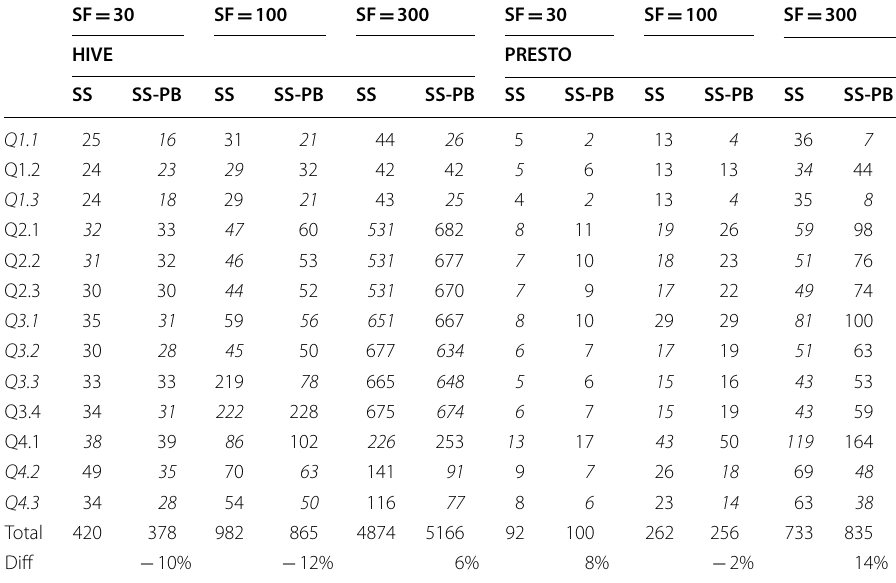
Italic values indicate the fastest processing time by query, workload, tool and data